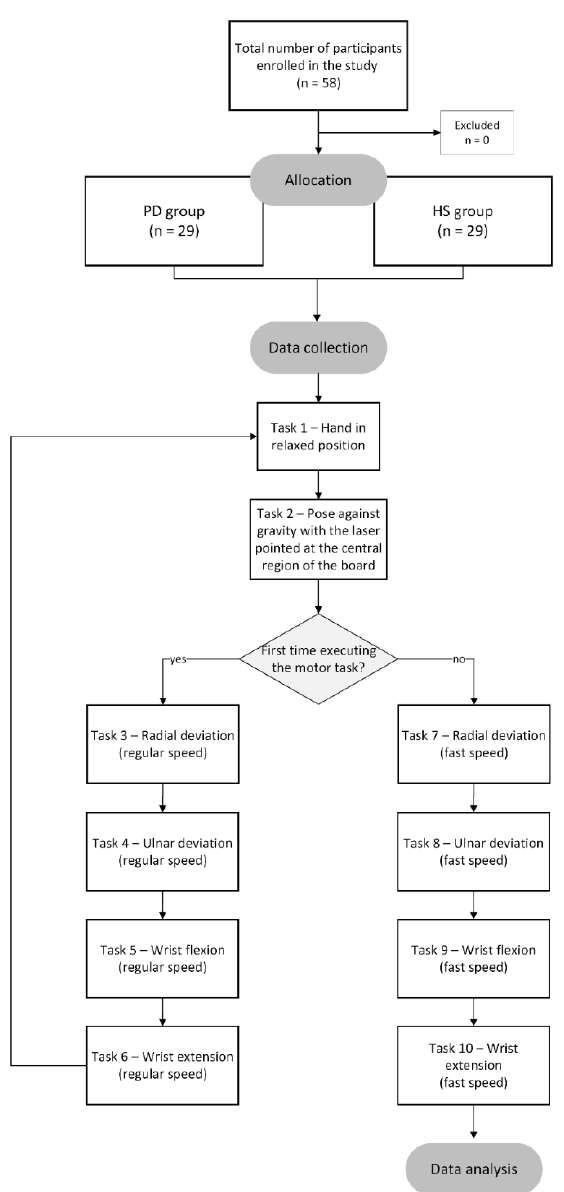
Figure 2. The study protocol shows volunteer allocation in PD and HS groups and presents the data collection protocol.